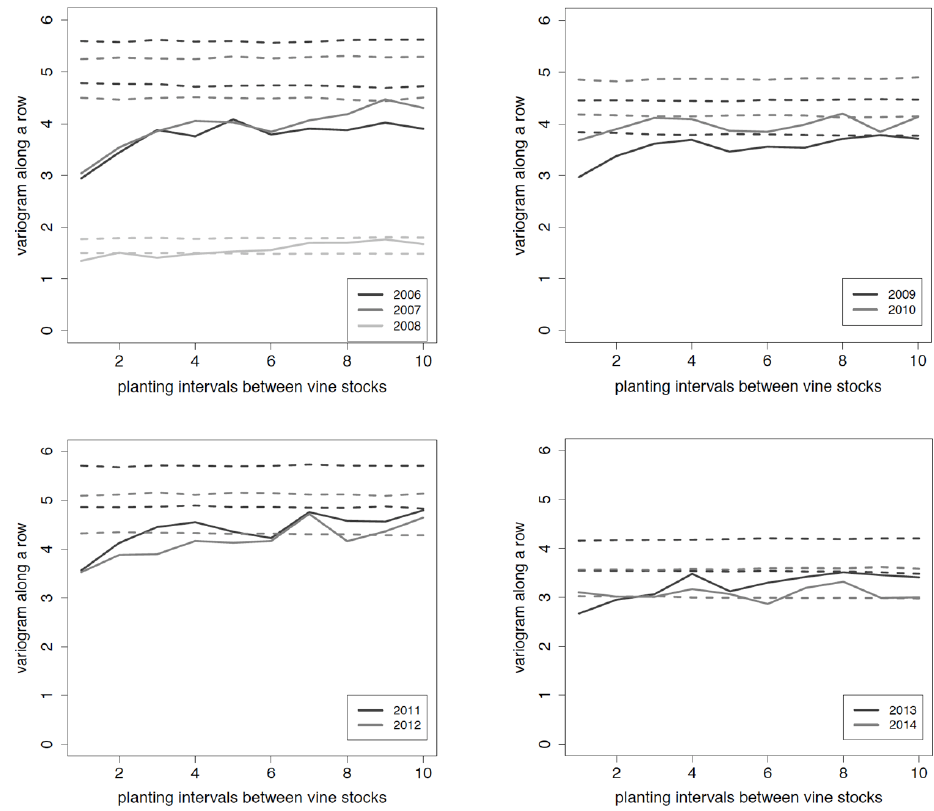
Figure 4. Estimated variograms and their confidence bands generated by permutation tests for spatial distribution of young females of Parthenolecanium corni in the Riesling plot. Solid lines represent variogram on P. corni numbers per vine. Dotted lines delineate the confidence bands at 95%. A spatial dependence among data is proven when the variogram (solid line) is outside the confidence band. x -axis: planting intervals between vine stocks; y -axis: value of the variogram along a row.